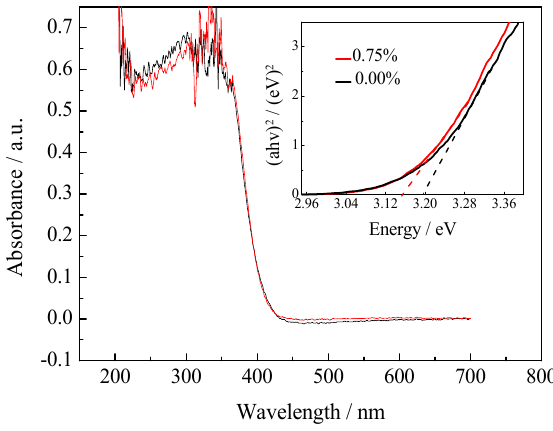
Figure 3. UV-vis diffuse reflectance spectroscopy (DRS) of pure TiO 2 and 0.75% La/TiO 2 .